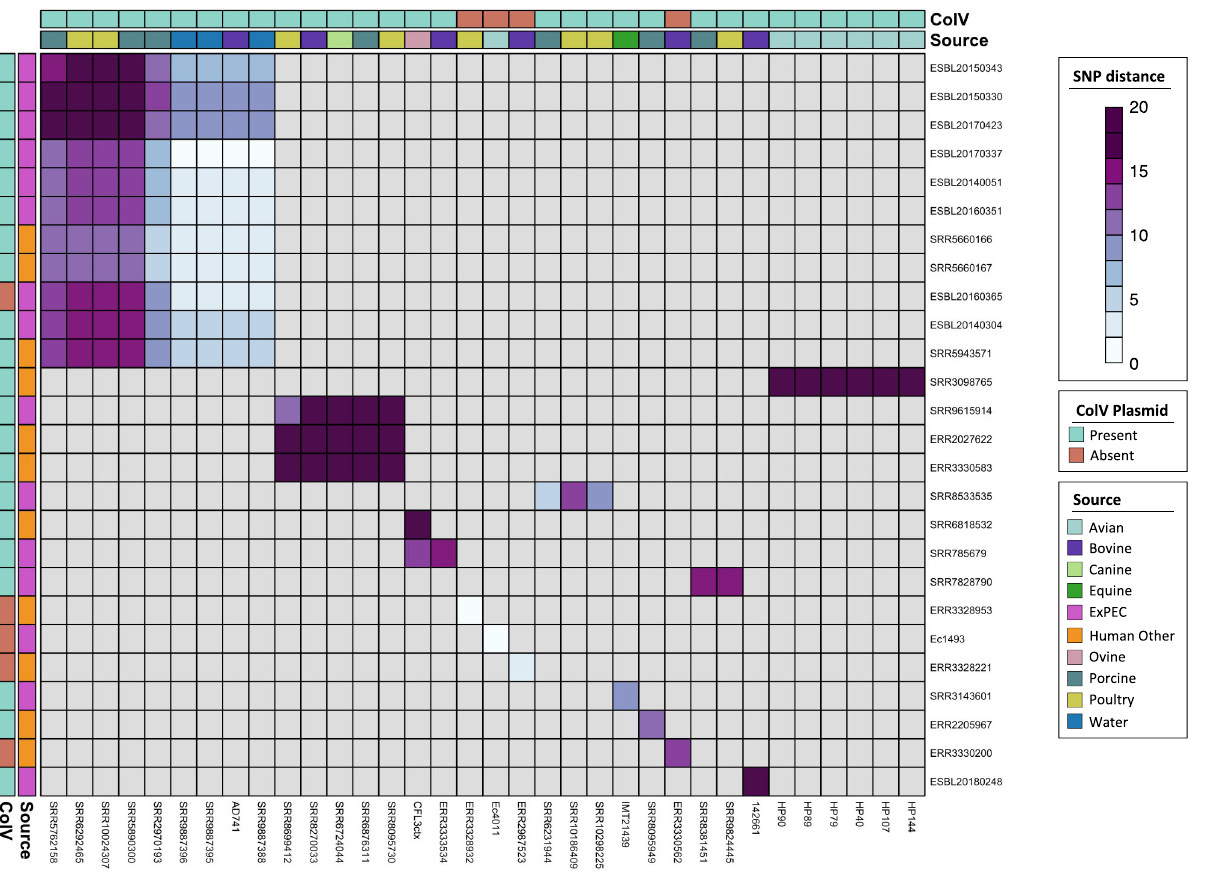
Fig. 9 Close relationships between human and non-human ST58. Heatmap of human vs. non-human strain pairs differing by ≤ 20 SNPs. Scale from white to dark purple represents SNPs from lowest to highest. Grey squares represent more distantly related sequence pairs. Heatmap is clustered to show groups of closely related